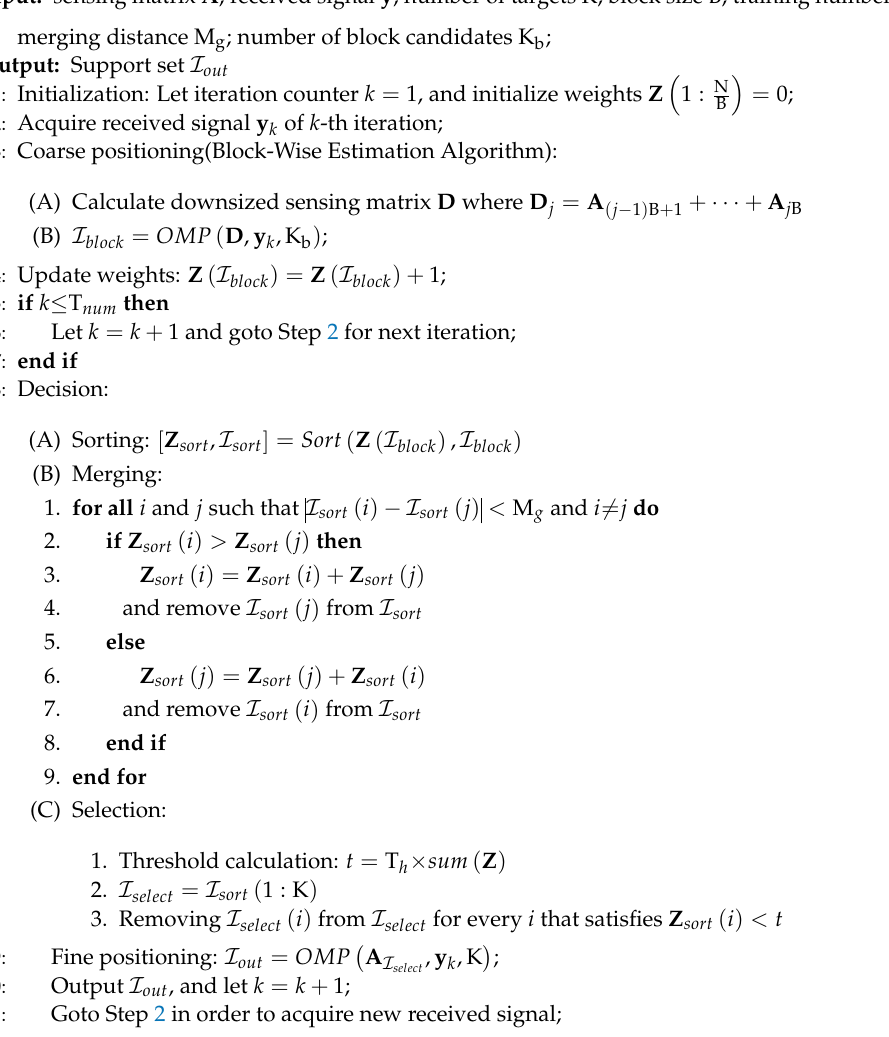
Algorithm 4 Proposed Two-Stage Reconstruction